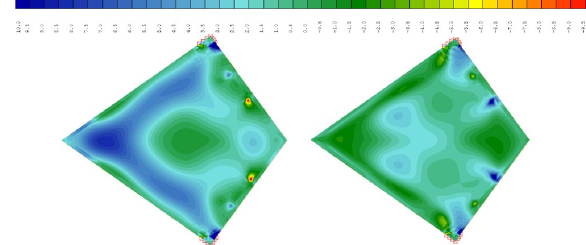
Figure 15: Principal stress in two directions, top and bottom surface The difference in stress of top and bottom surface in- dicates that the shell is subject to a combination of mem- brane forces and bending moment, which is shown in the Figure 16. Model FE4 is the closest representation of the actual shell roof included in this study. The stress distribution, shown in Figure 17 and 18 are similar to the stress in model FE3 in both magnitude and distribution, however with the difference that stress concentrations are evident at the tie- down supports. Themaximumprincipalcompressionfoundintheshell is 15 MPa (around edge beam and supports) which is well within limits of the concrete strength. Maximum princi-